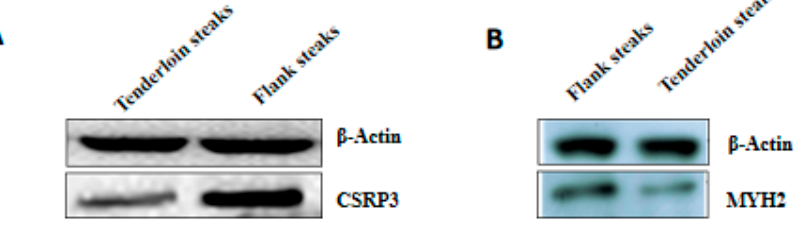
Figure 3. The relative expression levels of CSRP3 ( A ) and MYH2 ( B ) proteins between tenderloin and flank steaks in beef cattle. β -actin was used as an internal reference protein.